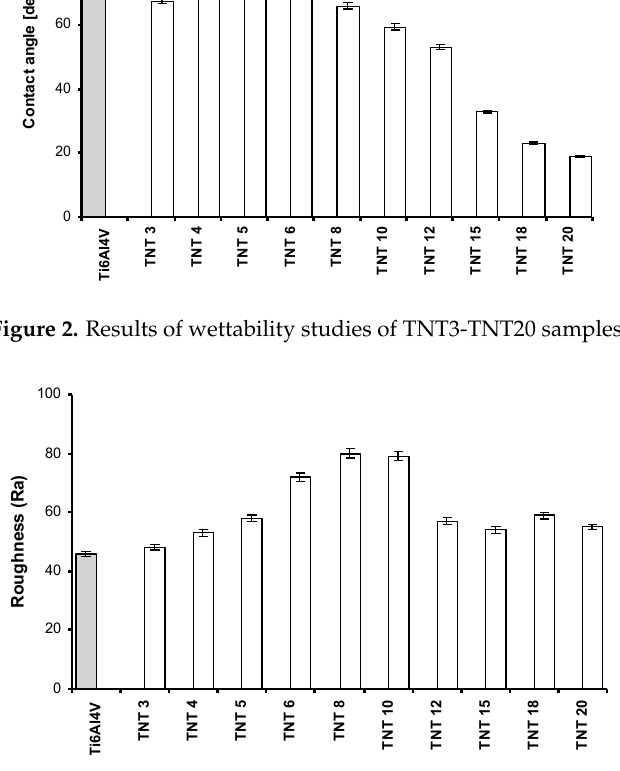
Figure 3. The surface roughness of TNT coatings determined by atomic force microscopy (AFM) data analysis.